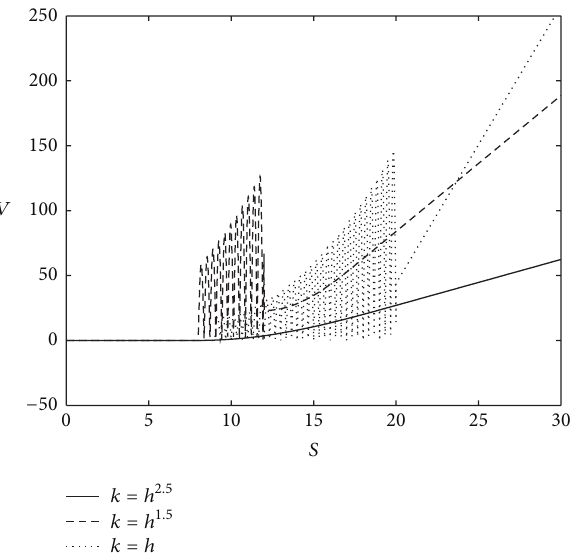
Figure 1: The effect of consistency condition on 𝑉